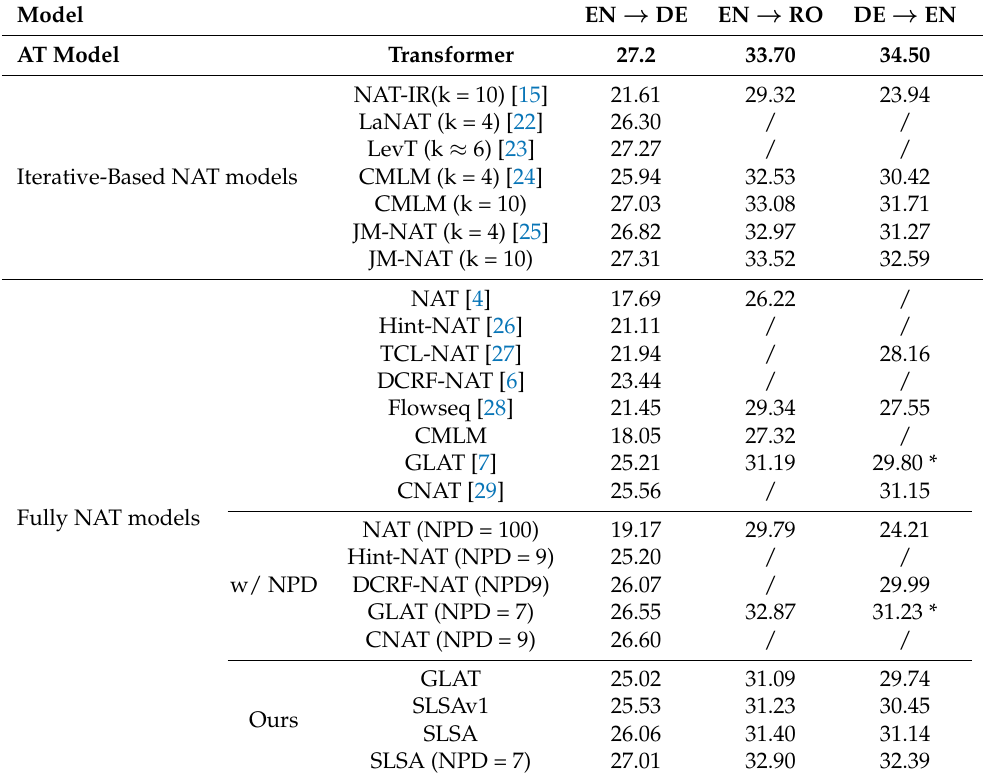
Table 1. The results of our model on the EN → DE, EN → RO, and DE → EN translation tasks. “NPD” represents noisy parallel decoding. “/” indicates there are no values in this term. “*” denotes the results are obtained by our reimplementation. “k” denotes the number of decoding iterations. Model EN → DE EN → RO DE → EN AT Model Transformer